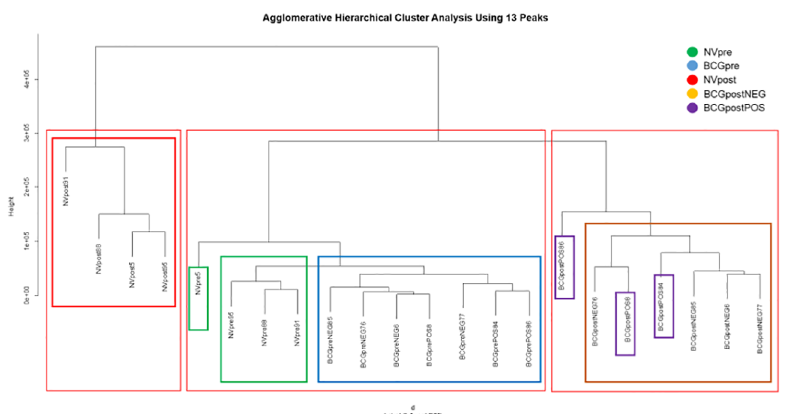
Fig 4. Agglomerative hierarchical cluster analysis dendrogram constructed using 13 peaks. Initial pairingsresultedin groupingof like samples.In the next hierarchical grouping,three NVpre samples (NVpre88, 91 and 95) appearmore closely associatedwith the BCGpre sample group than NVpre5, and two BCGpostPOS (BCGpostPOS4 and 8) samples group with the BCGpostNEG samples. The final hierarchical divisionidentifies the NVpost samples as a distinct group separatefrom the groupedpre-challengesamples, and the post-challengeBCG-vaccinatedsamples.